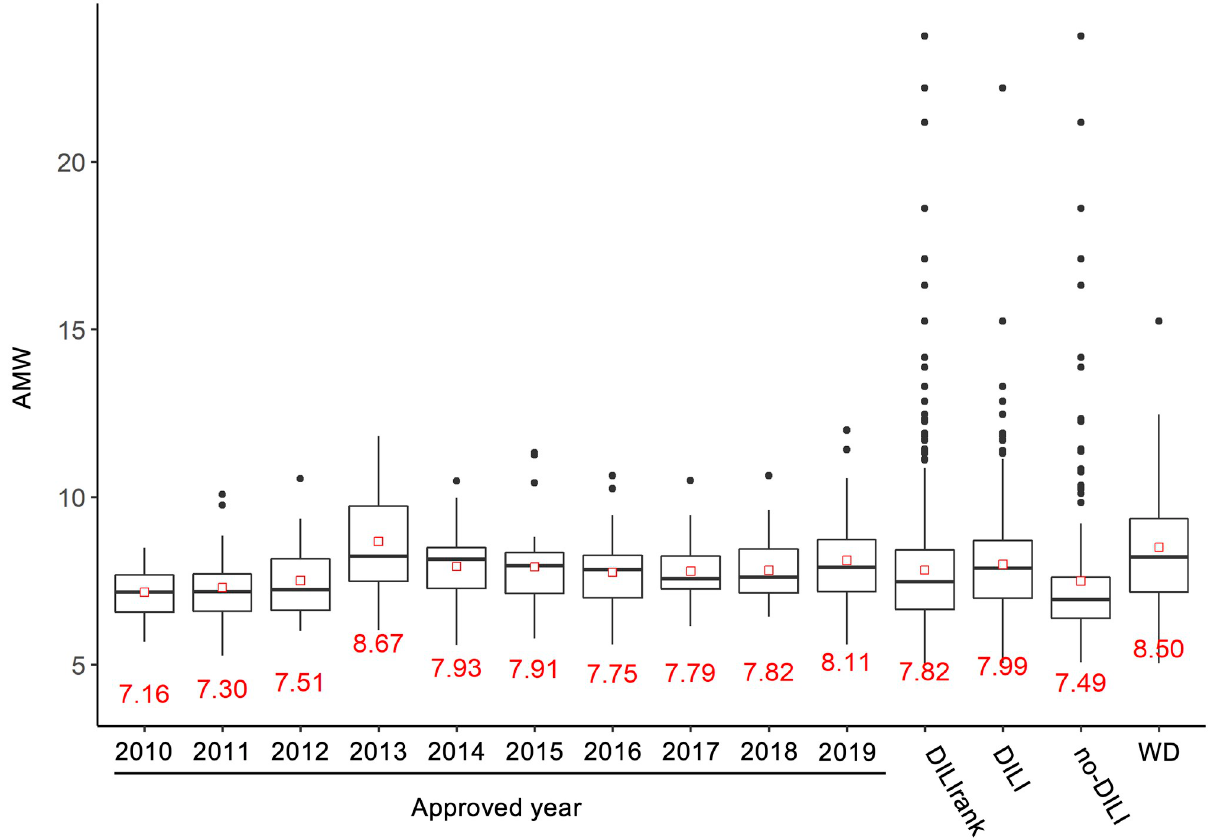
Fig 5. The trend of AMW of newly approved drugs. The AMW values of newly approved drugs for each year in EU, US and Japan were calculated. The numbers of drugs included are 18, 26, 29, 15, 38, 31, 30, 29, 40 and 50 in the year of 2010, 2011, 2012, 2013, 2014, 2015, 2016, 2017, 2018 and 2019, respectively. The list of drugs is shown in S3 Table. The values of the 652 drugs are also shown as references. The information of withdrawn drugs (WD) was obtained from